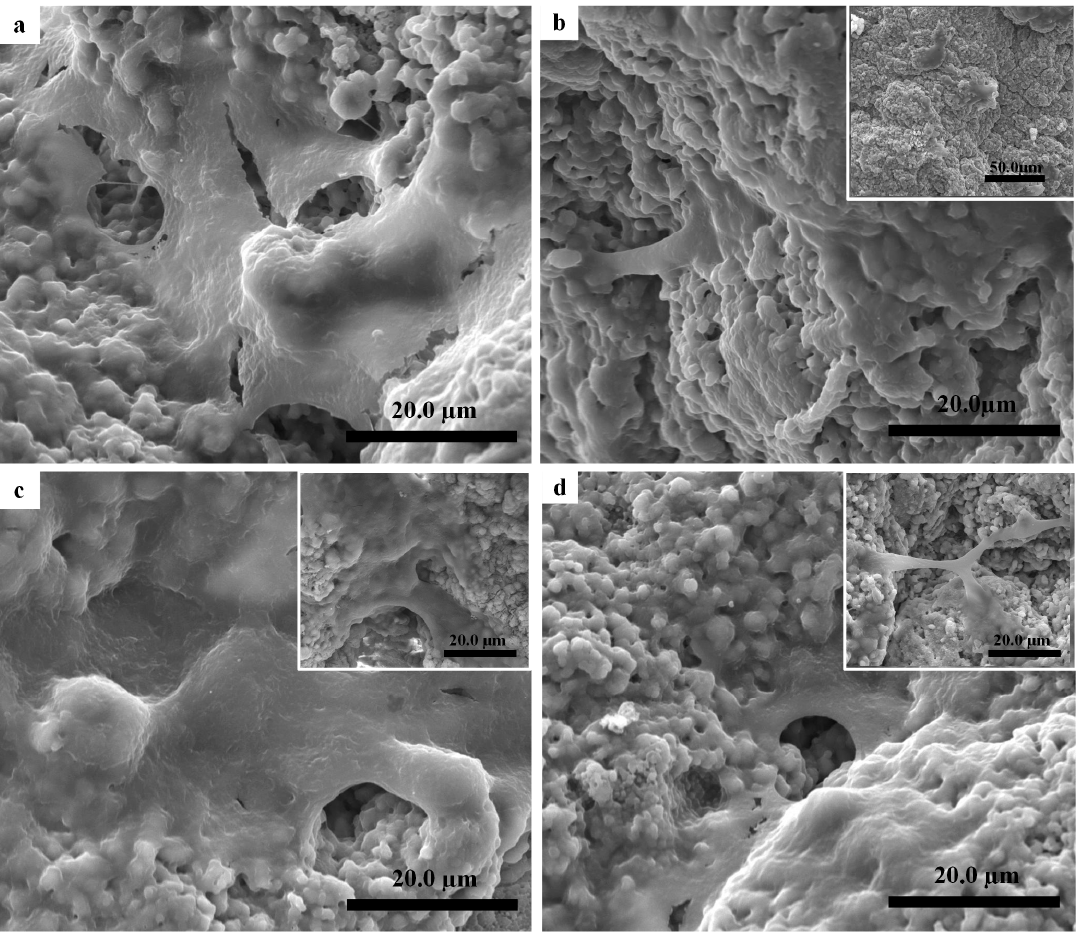
Figure 7. SEM images illustrated endothelial cell (EC) culture after five days: ( a ) as-sintered HA scaffold; ( b ) Cu 3 -HA scaffold sphere-like structures; ( c ) Cu 5 -HA scaffold flower-like structures; and ( d ) Cu 7 -HA nano-structed structures.